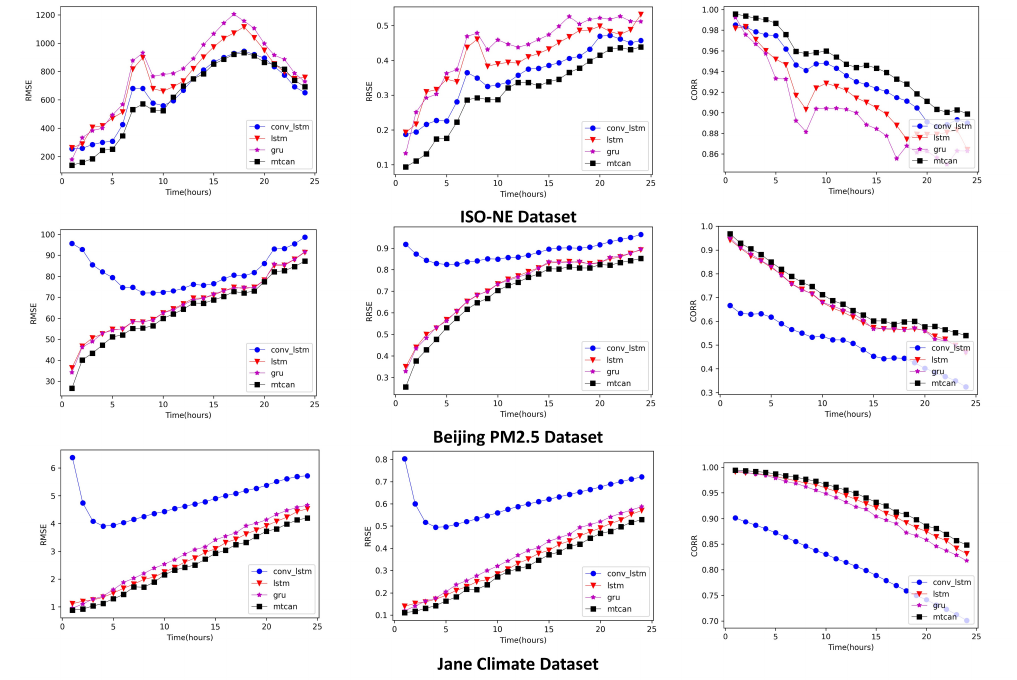
Figure 6. The RMSE, RRSE, and CORR for each lead time from 1 to 24 h vs. different algorithms over the ISO-NE Dataset, Peijing PM2.5 Dataset, and Jane Climate